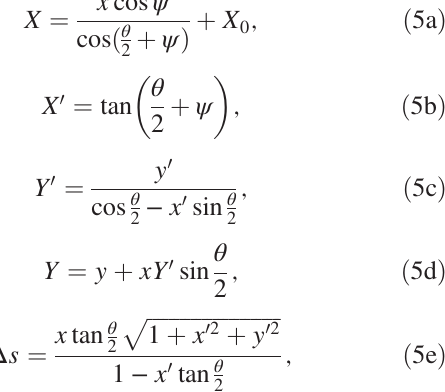
ffiffiffiffiffiffiffiffiffiffiffiffiffiffiffiffiffiffiffiffiffiffiffiffiffi p 1 þ x 0 2 þ y 0 2